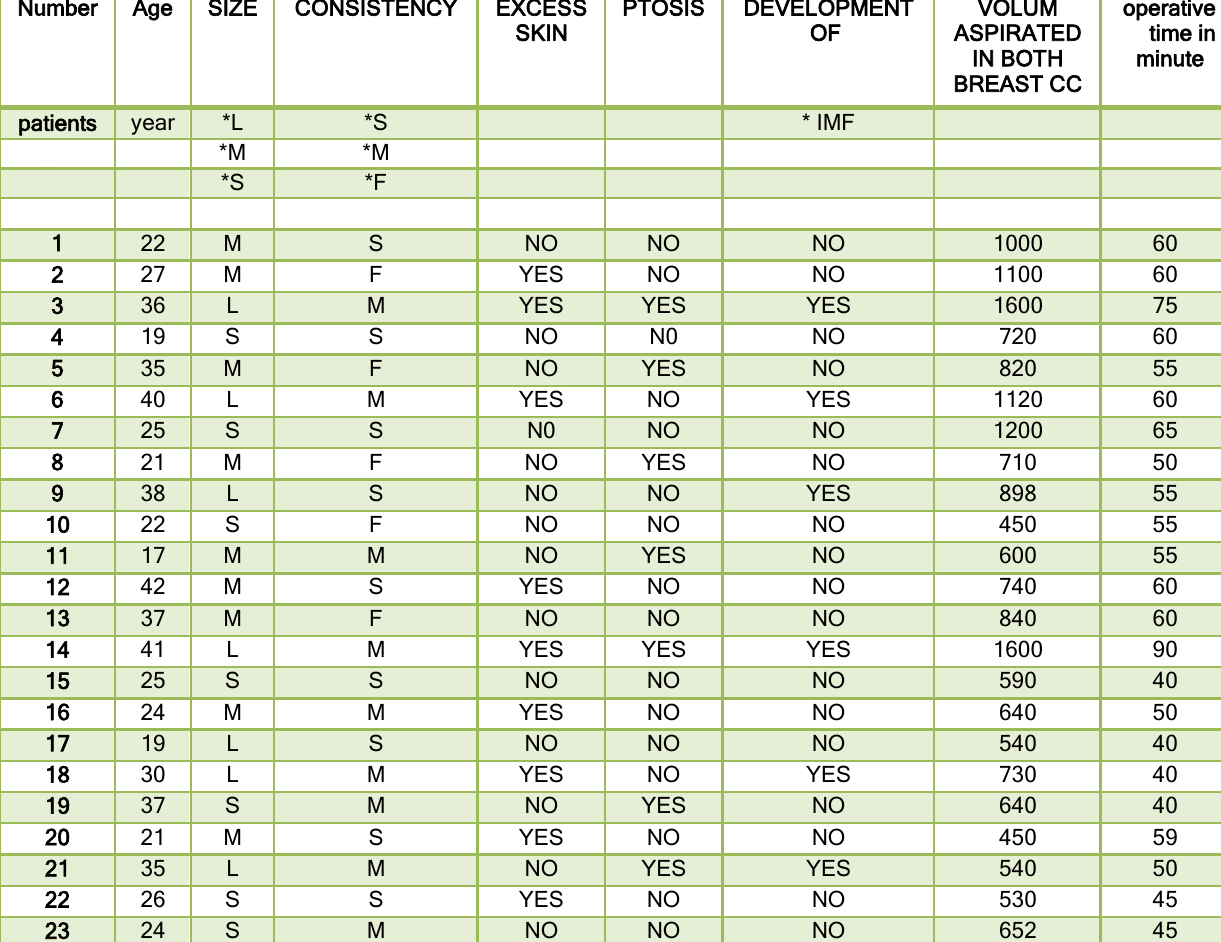
Table-1- Showing data collection for the consecutive patients Number Age